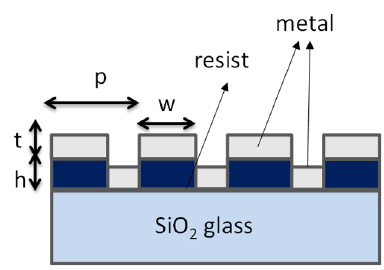
Fig. 1. Schematic drawing of double-layer wire grid